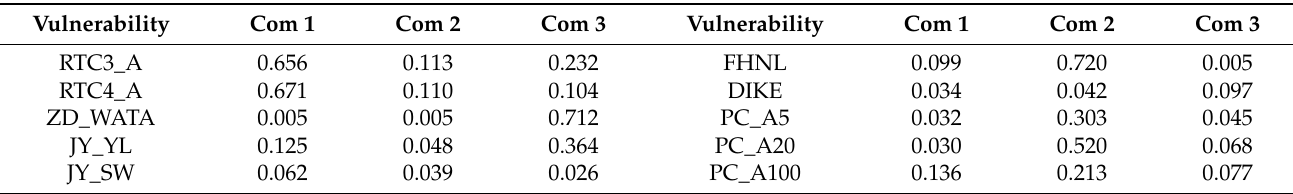
Table 9. Results of Analysis of Vulnerability Factors.